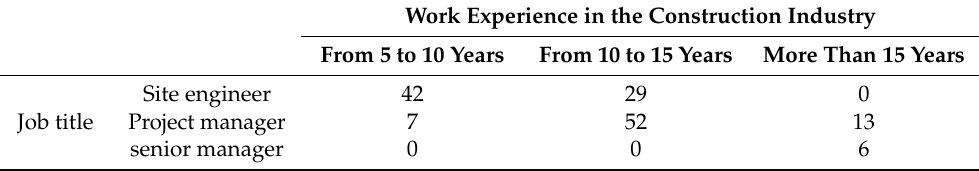
Table 6. The demographic data regarding the respondents.